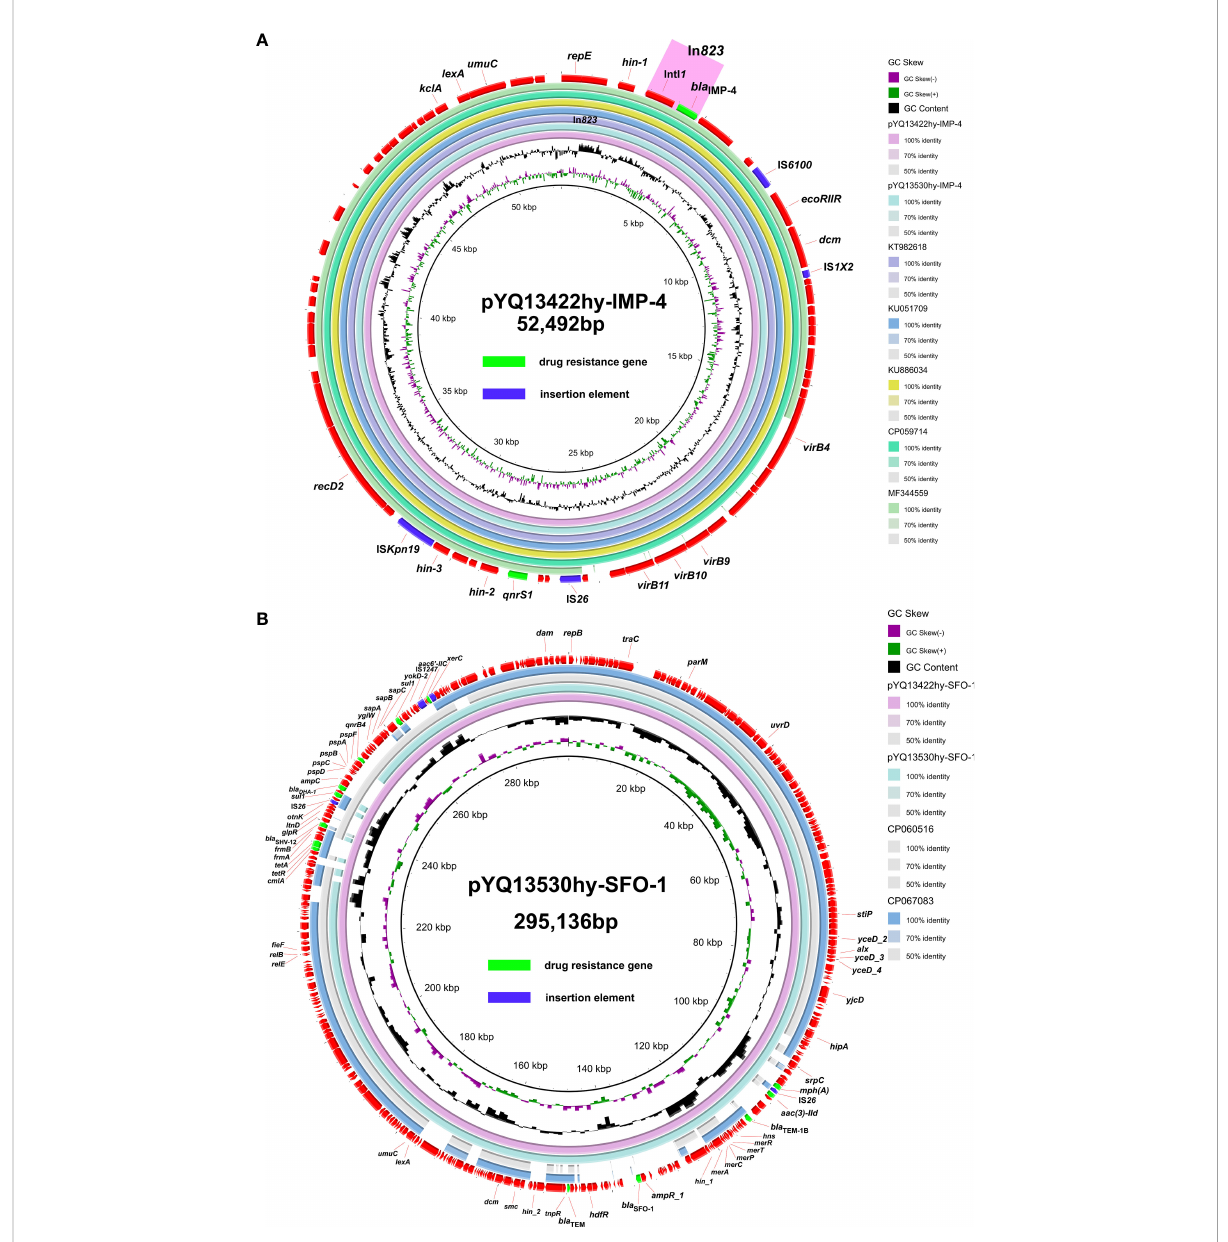
FIGURE 2 Genomic analyses of plasmid pYQ13422-IMP-4 (A) and pYQ13422-SFO-1 (B) . The comparative plasmid circular map of pYQ13422-IMP-4 and pYQ13422-SFO-1, generated using BLAST Ring Image Generator (BRIG), shows the genes and their